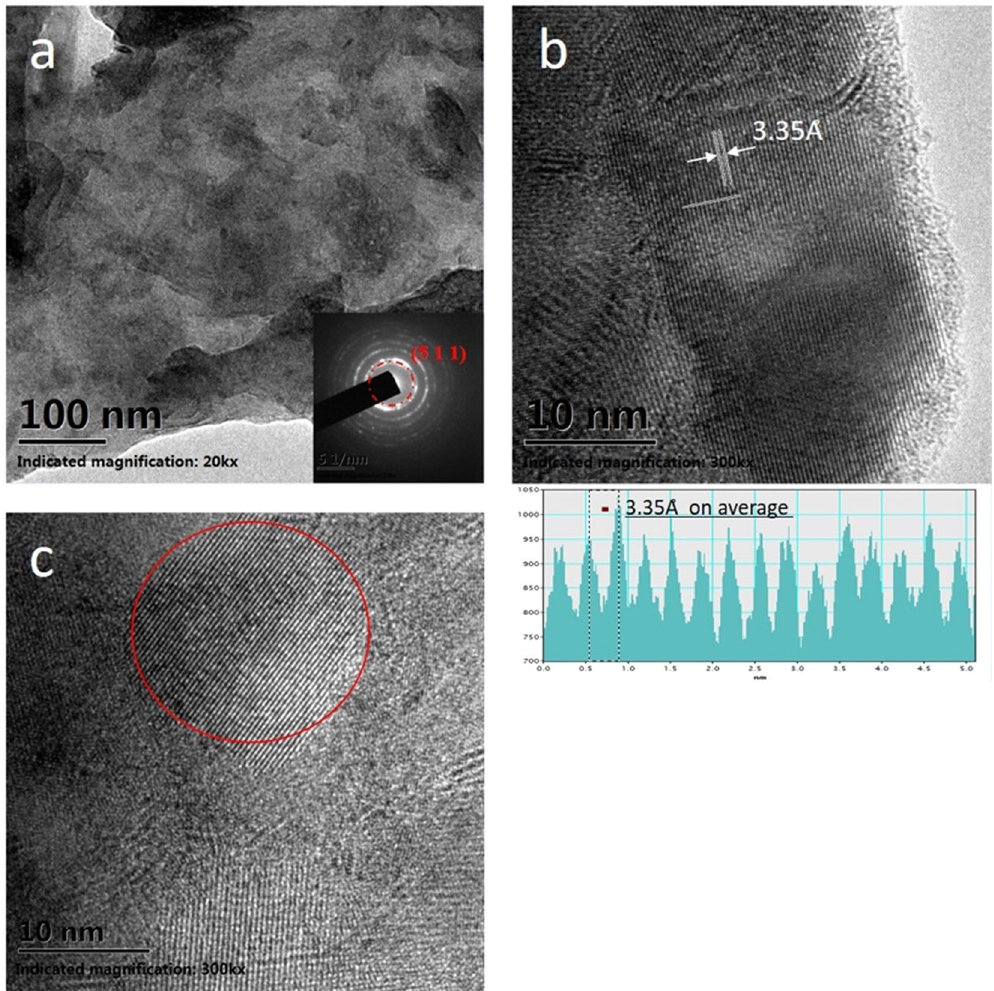
Figure 3. ( a ) Overview TEM images of the few layer In 2 Te 3 and SAED patterns (inset). ( b ) Few layer In 2 Te 3 combines the crystalline areas with lattice spacing of 3.35 Å and less crystalline areas. ( c ) The ordering phase in red circle interspaced by disordered